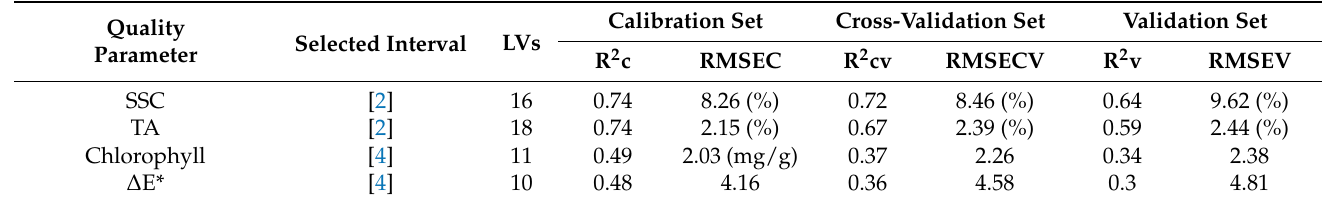
Table 5. Results of the models with the optimal intervals for different quality